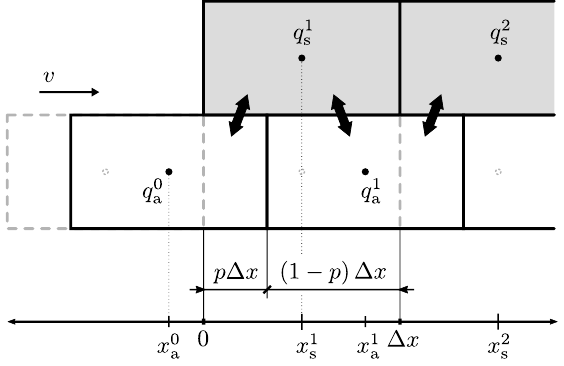
Figure 1. Illustration of the advected grid movement against the static